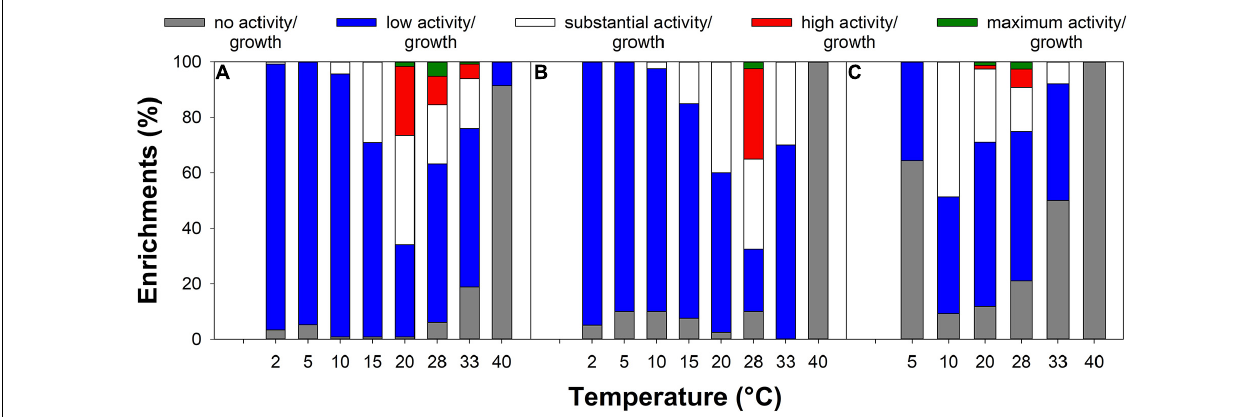
FIGURE 4 | Effect of temperature on growth (A) or activity (B,C) of arsenic-tolerant (A) , arsenite-oxidizing (B) , and arsenate-respiring (C) enrichments. All observed growth and turnover rates were divided by the highest observed growth/turnover rate observed for the respective isolation approach and scored as follows: no observed activity/growth (0–2% of maximum), low activity/growth (2–24% of maximum), substantial activity/growth (25–49% of maximum), high activity/growth (50–74% of maximum), and maximum activity/growth (75–100% of maximum).